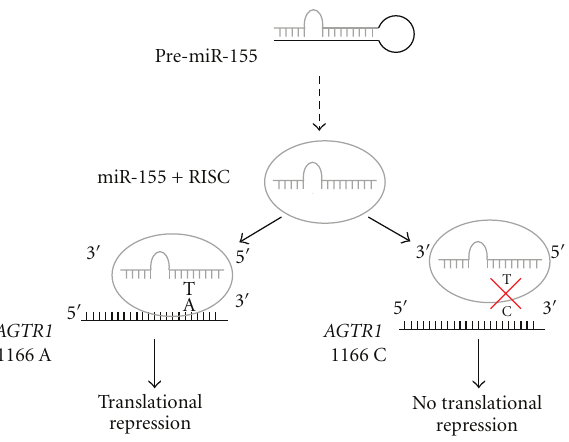
Figure 1: Model of miR-155 binding to the 3 (cid:3) UTR of AGTR1 and association with the 1166A > C polymorphism (rs5186) . The hairpin-shaped precursor of miR-155 (pre-miR-155) after being exported in the cytoplasm is assembled into the RNA-induced silencing (RISC) complex (mature miR-155), which transfers it to recognise specific mRNA targets. miR-155 binds with complete sequence complementarity to its target mRNA seed site and induces posttranscriptional gene silencing. In the presence of the − 1166 C allele in the 3 (cid:3) UTR of AGTR1, the compensatory base pairing is a ff ected, and miR-155 binding is inhibited leading to increased AGTR1